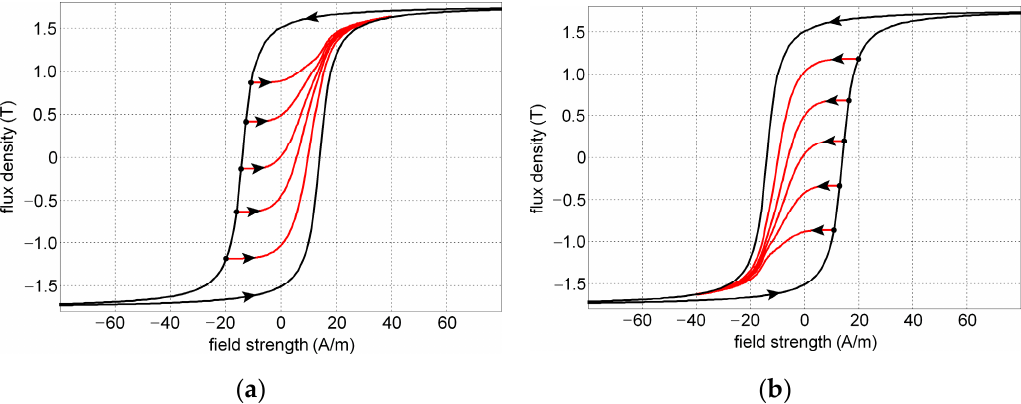
Figure 7. Family of the first-reversal curves of transformer sheet M120-27S: ( a ) increasing values of the field strength; ( b ) decreasing values of the field strength.